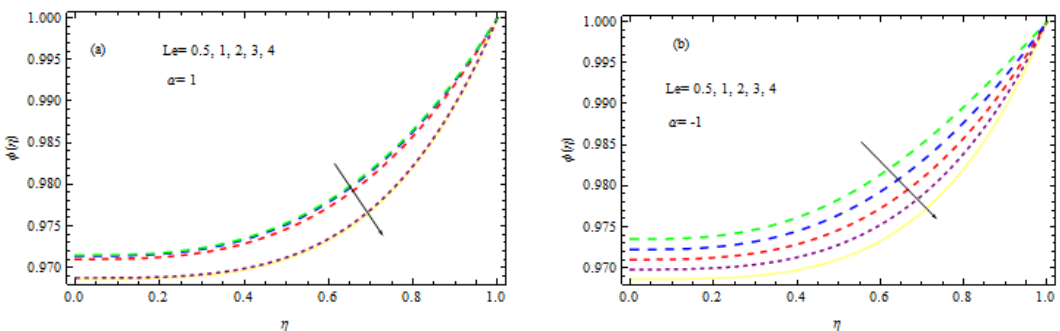
Figure 18. ( a , b ) Influence of 𝐿𝑒 on concentration.